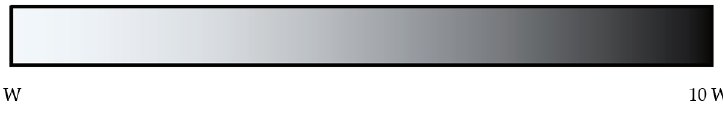
Figure 17. The meaning of the depth of